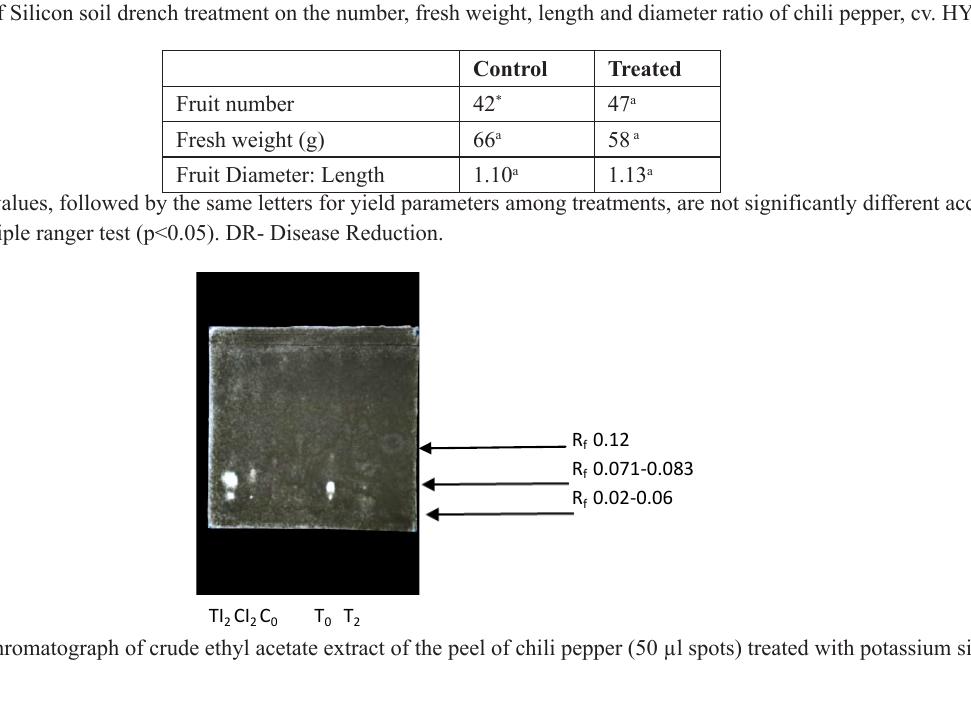
Figure 4: TLC chromatograph of crude ethyl acetate extract of the peel of chili pepper (50 µl spots) treated with potassium silicate (Kasil®) .